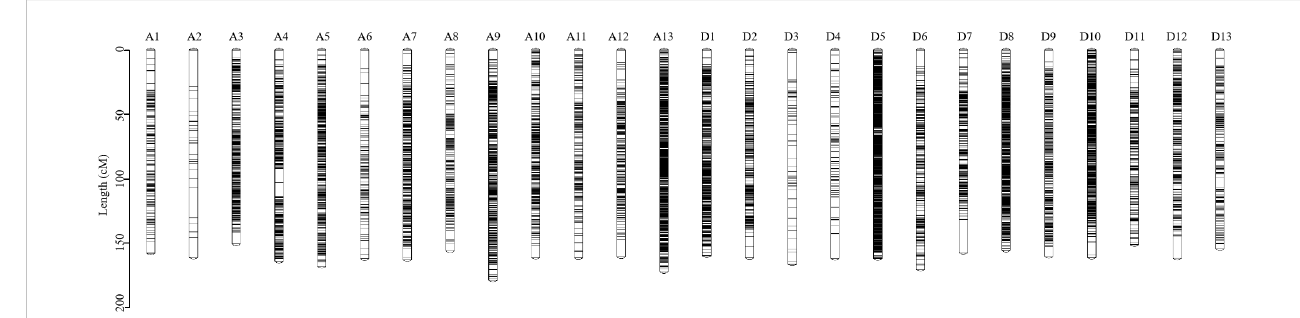
FIGURE 1 Marker distribution of the constructed genetic